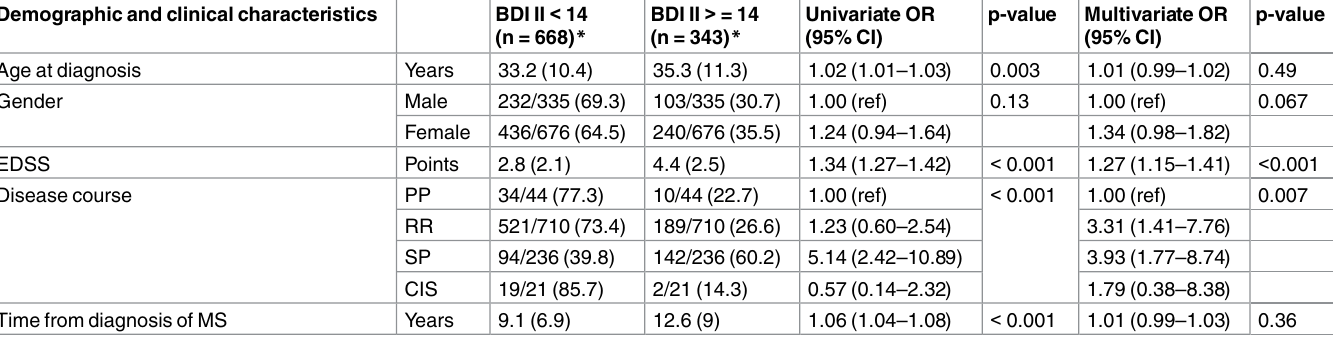
Table 2. Distribution of demographic and clinicalcharacteristicsaccordingto depressivesymptoms. Demographic and clinical